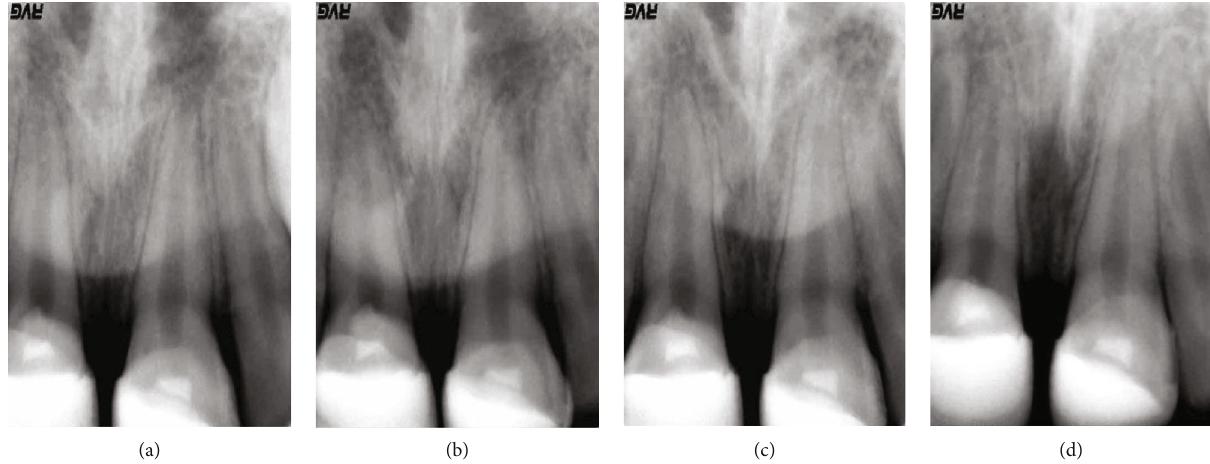
Figure 7: Periapical radiography, at 2 months (a), 1 year (b), 2 years (c), and 3 years (d) after trauma.